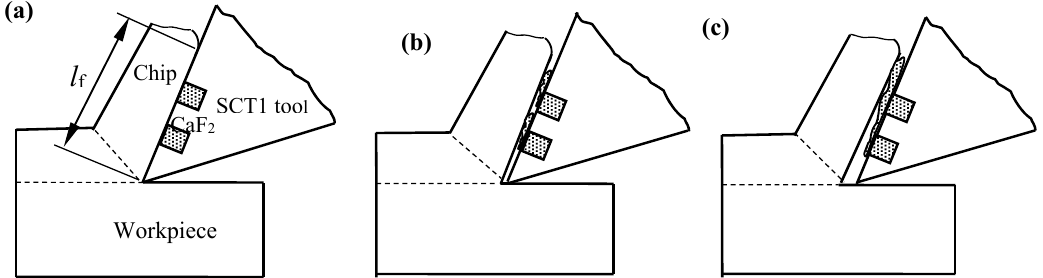
Figure 17. Lubricating model of SCT1 tool in machining process: ( a ) cutting beginning; ( b ) CaF 2 solid lubricant piled out; ( c ) film forming.